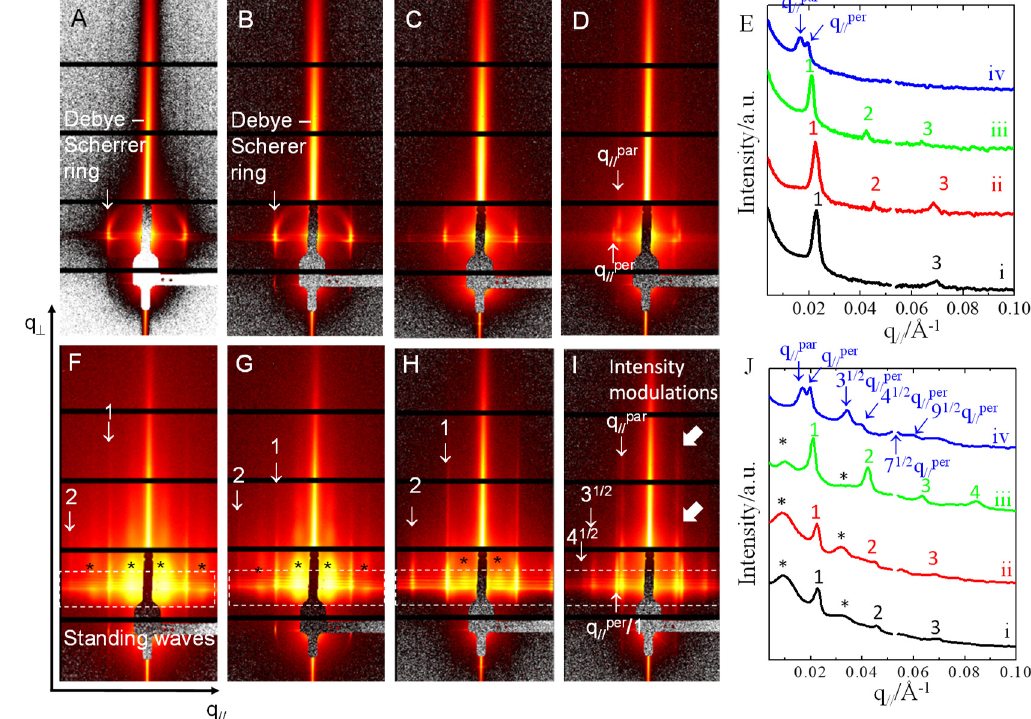
Figure 3. ( A – D , F – I ) GISAXS 2D patterns and ( E , J ) 1D profiles of thin films ( h i = 97 nm) of P(S 21 -b-M 21 )/PS 6 mixtures of various weight fractions: ( A , E i , F , J i ) 100/0, ( B , E ii , G , J ii ) 95/5, ( C , E iii , H , J iii ) 75/25 and ( D , E iv , I , J iv ) 50/50, respectively. The films were spin-coated on PS 270n -SiO x /Si and annealed at 230 °C for 1 h. Broad rods, corresponding to the scattering of wrinkles, are marked by black asteroids (*). The positions of the diffraction truncation rods are labelled by q // ratios, and standing waves are highlighted by dotted boxes for a visual guide. In ( E , J ), lines i − iv correspond to the 1D GISAXS profiles extracted from in-plane scan cuts along the intense streaks. Broad humps, a scattering feature of wrinkles, are marked by black asteroids (*).